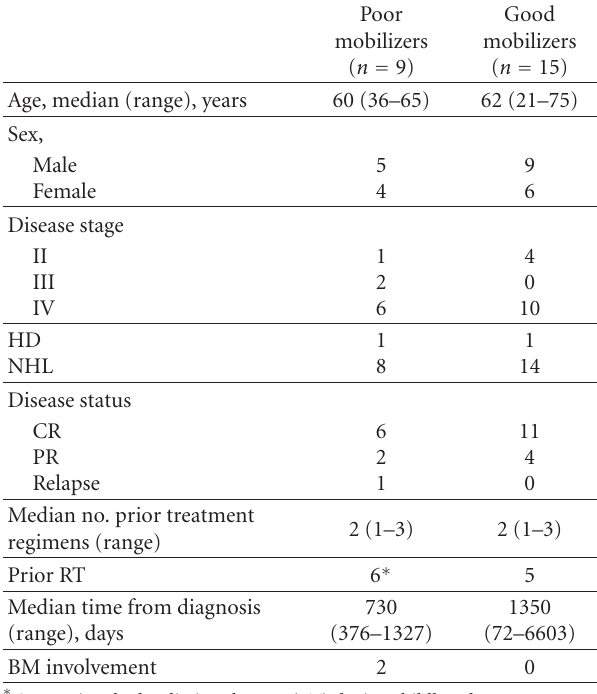
Table 1: Patient characteristics: MM patients. Table 2: Patient characteristics: lymphoma patients.